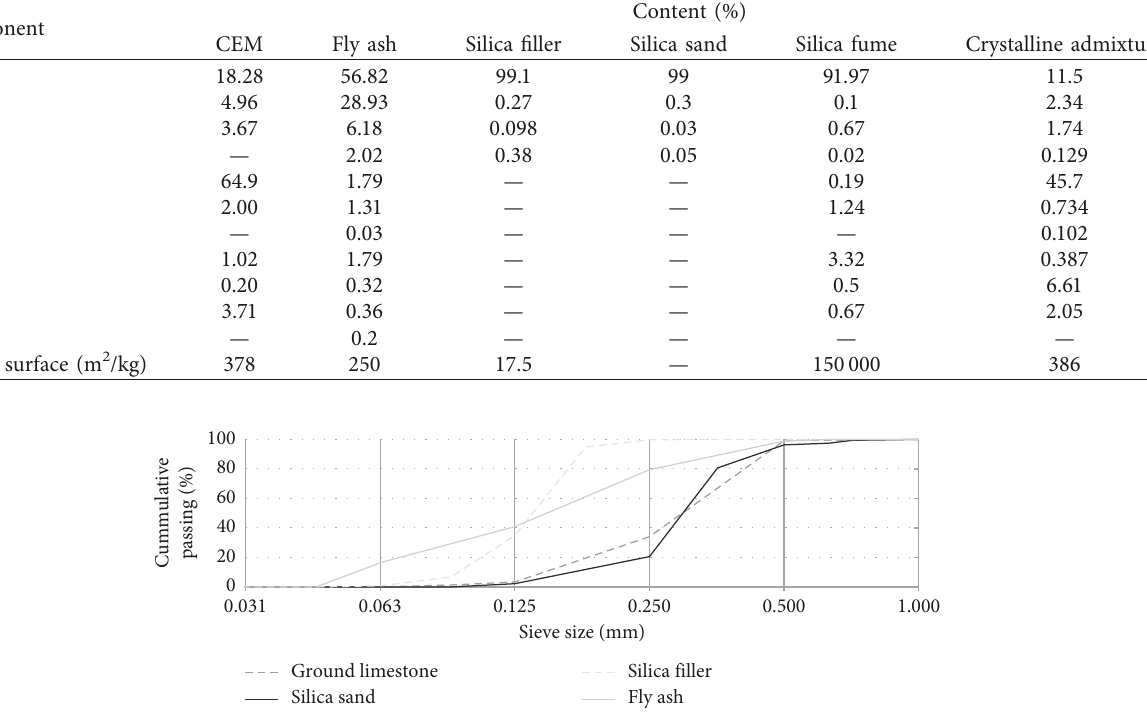
Figure 3: Particle size distribution of raw materials.